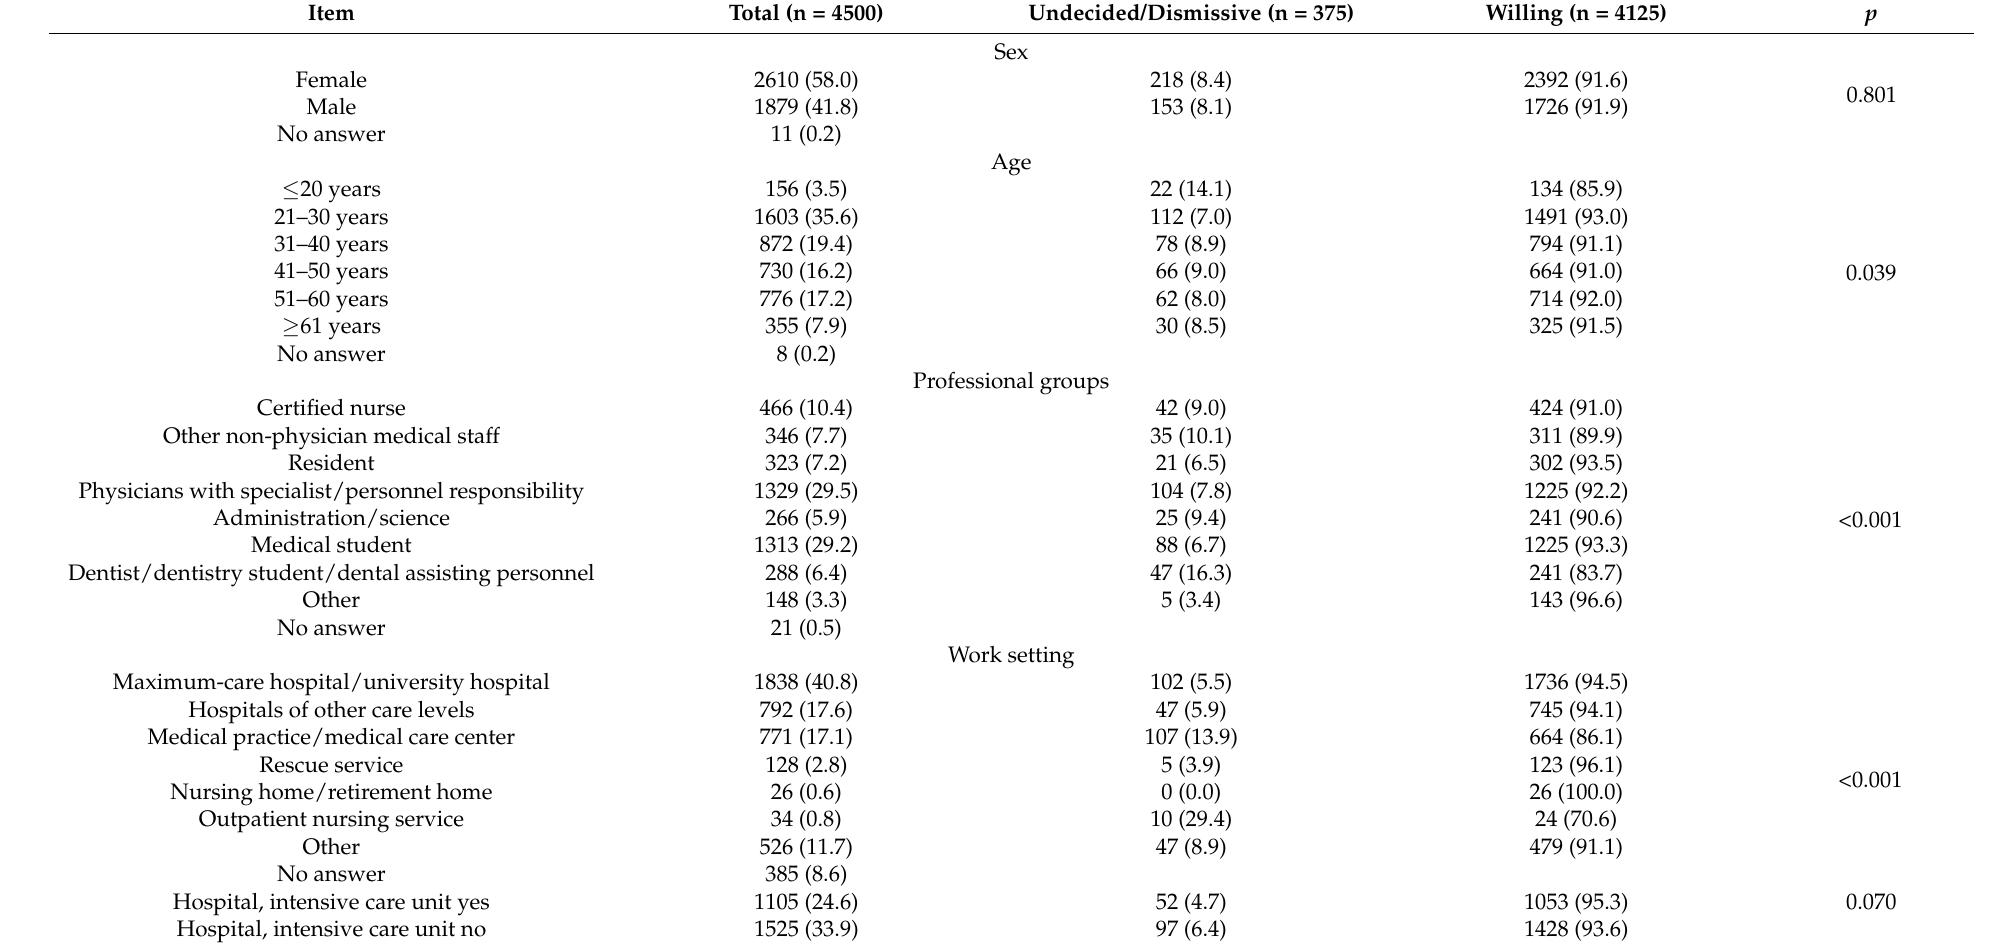
Table 1. Overall study population, and differences between participants undecided/dismissive or willing to receive COVID-19